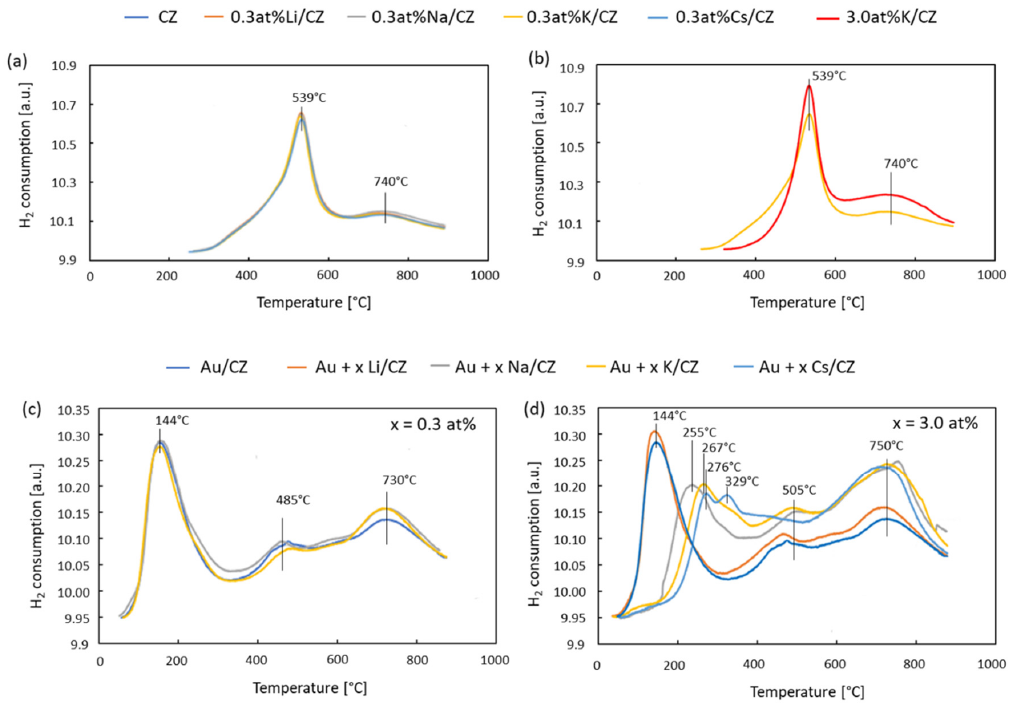
Figure 7. TPR profiles of ( a ) cerium–zirconium mixed oxide doped with 0.3 at% Li, Na, K and Cs ions, ( b ) comparison of 0.3 at% K/CZ and 3.0 at% K/CZ, ( c ) Au + 0.3 at% alkali metal ions/CZ and ( d ) Au + 3.0 at% alkali metal ions/CZ.